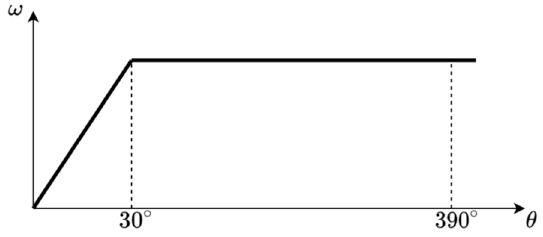
Figure 7. The speed profile of the servo system in a function of the relative angular movement.